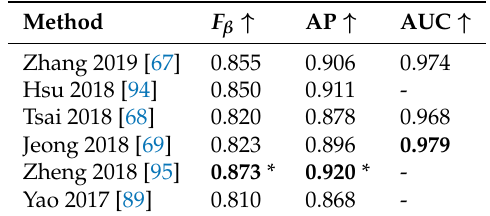
Table 8. Quantitative comparison of selected methods for co-saliency estimation on the iCoseg dataset. Best results are highlighted in